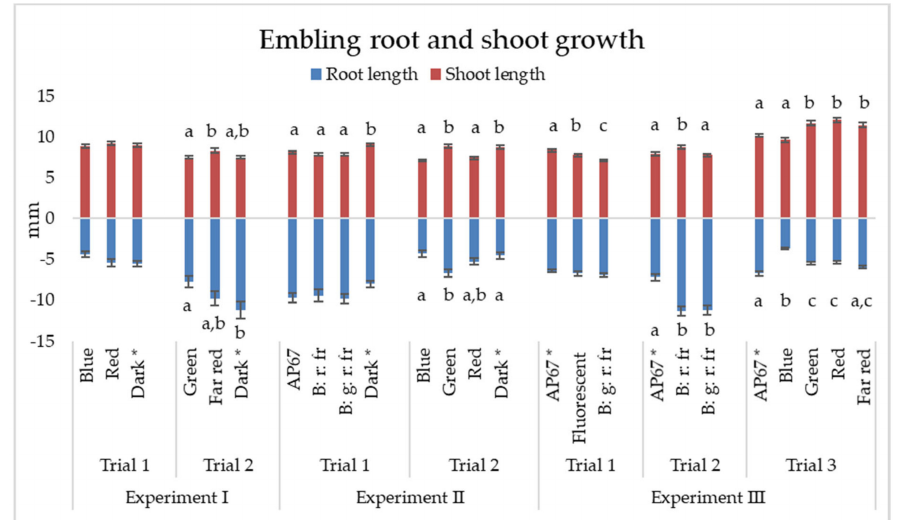
Figure 5. The root and shoot length of germinated embryos from Experiment I, in which ET was grown under different light spectra, the embryos were matured in dark and germinated under AP67 light; Experiment II in which embryos from ETs grown in dark were matured for the last 26 days under different spectra and then germinated under AP67 light; and from Experiment III in which embryos from ET grown and matured in the dark were germinated under different spectra. The mean values are presented with standard error bars. The asterisks (*) in the different experiments represent the same control treatment in which ET was proliferated, and somatic embryos were matured in the dark, and the embryos were germinated under light in the AP67 spectrum. Significant differences within each trial are marked with differing letters. The 95% confidence level was used. The differences in root and shoot lengths between SE lines are illustrated in Supplementary Figures S2–S4.